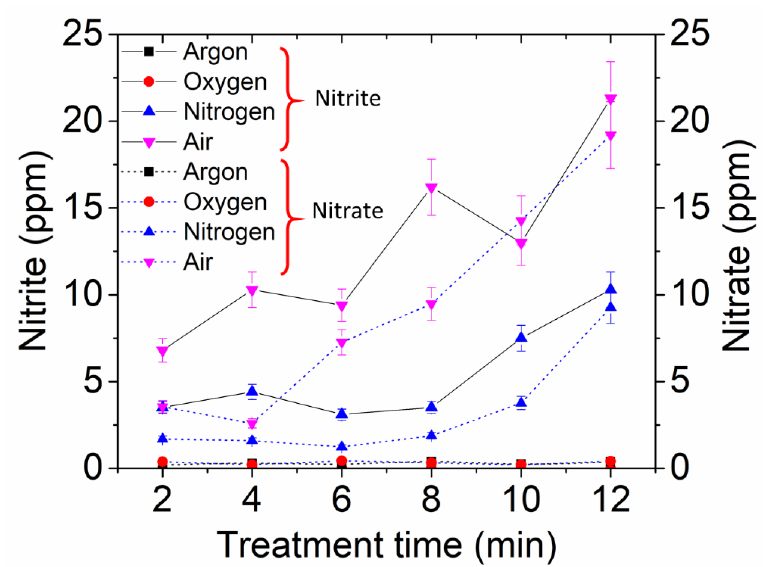
Figure 6. Nitrite and nitrate measurements inside the plasma-activated water with four gas feedings: argon, oxygen, nitrogen, and air using an ion chromatography